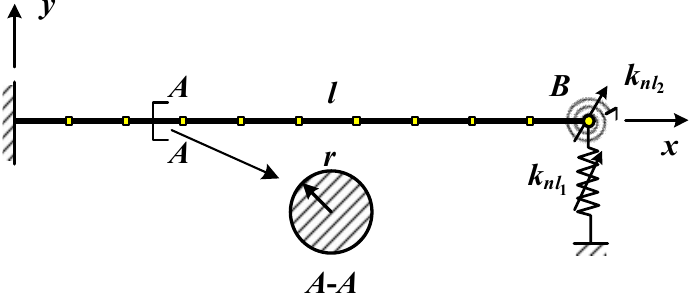
Figure 8. Cantilever beam with locally nonlinear springs.